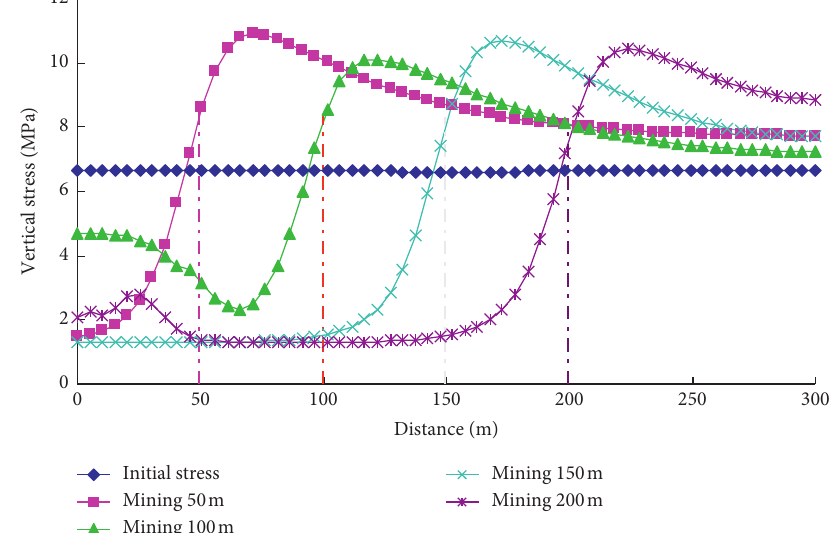
Figure 17: Vertical stress distribution of strata strike in roadway of lower slice after upper slice